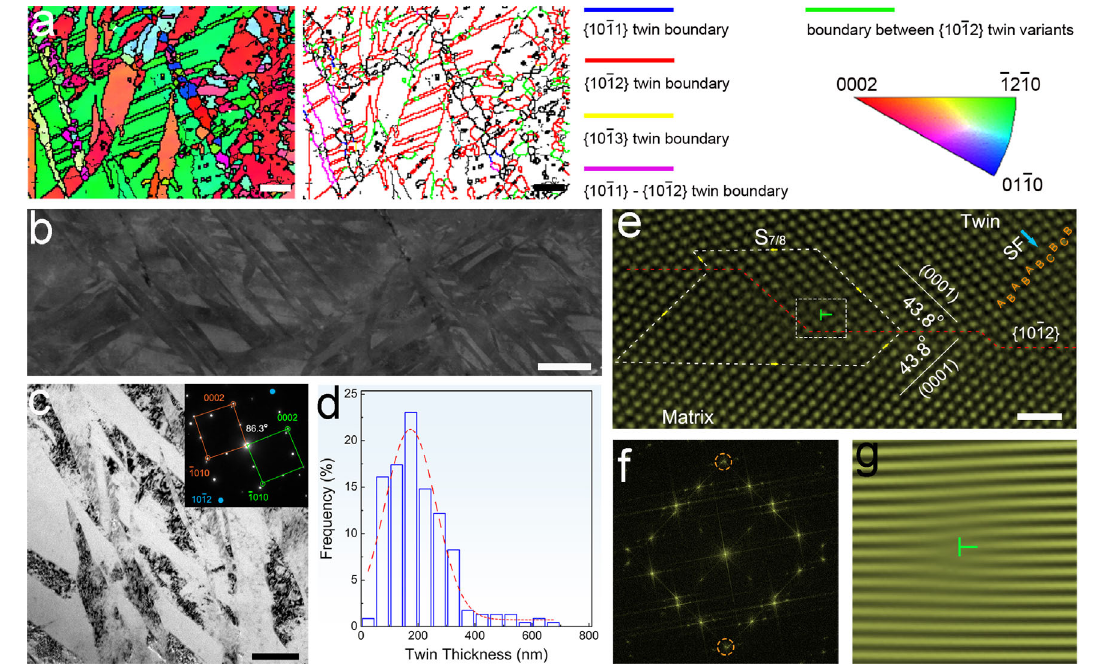
Fig. 1 Microstructure of high-density twins. a Inverse pole fi gure map and boundary misorientation map for UFT-4, scale bar = 2 μ m. b Electron channeling contrast image of twins in UFT-4, scale bar = 2 μ m. c Transmission electron microscopy (TEM) image, scale bar = 500 nm. d Distribution of twin thickness in UFT-4; ( e ) HAADF-STEM image for f 10 (cid:1) 12 g twin boundary, scale bar = 1 nm; ( f ) Fast Fourier transform pattern; ( g ) Dislocation displayed by the IFFT lattice fringe image generated by mask f 10 (cid:1) 12 g diffractions of two crystals in an image ( f ). Solid solution-treated AZ80 with compression passes for 1, 3, 6, and 12 are designated as UFT-1, UFT-2, UFT-3, and UFT-4, respectively. SF and S 7/8 in e denote stacking fault and twinning dislocation around the step,